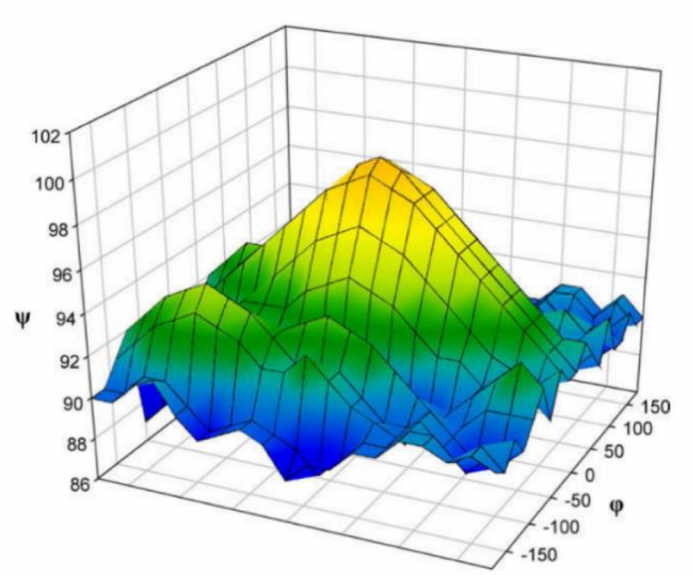
Figure 49. The 13 C-NMR chemical shift surfaces of the anomeric carbon of D-Glcp- α -(1 → 4)-D-Glcp disaccharide. Reproduced from Tafazzoli and Ghiasi [164] with the permission of